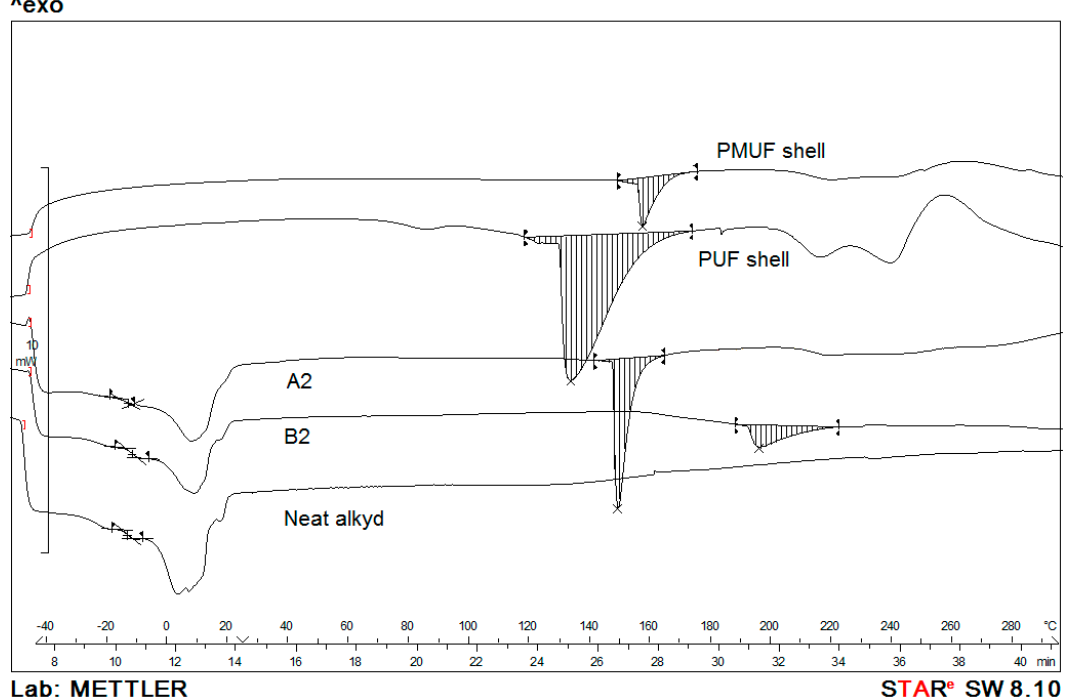
Figure 9. DSC thermograms of samples A2 and B2, the neat alkyd and shell materials.